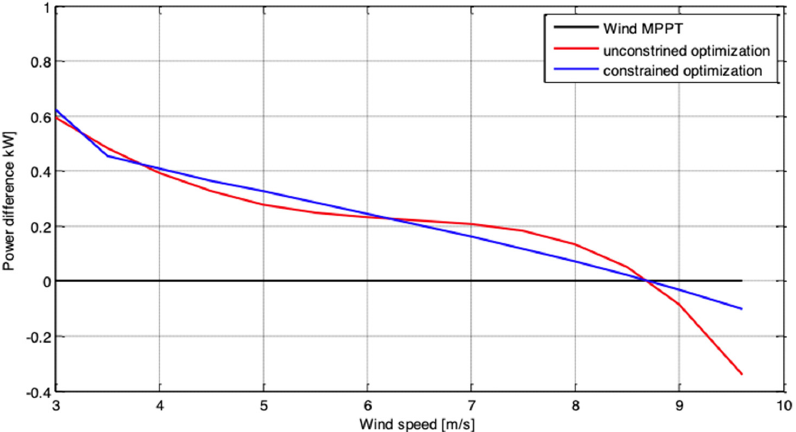
Figure 8. Comparison of output power differences (in kW) for different optimization approaches for the selected HSWT.